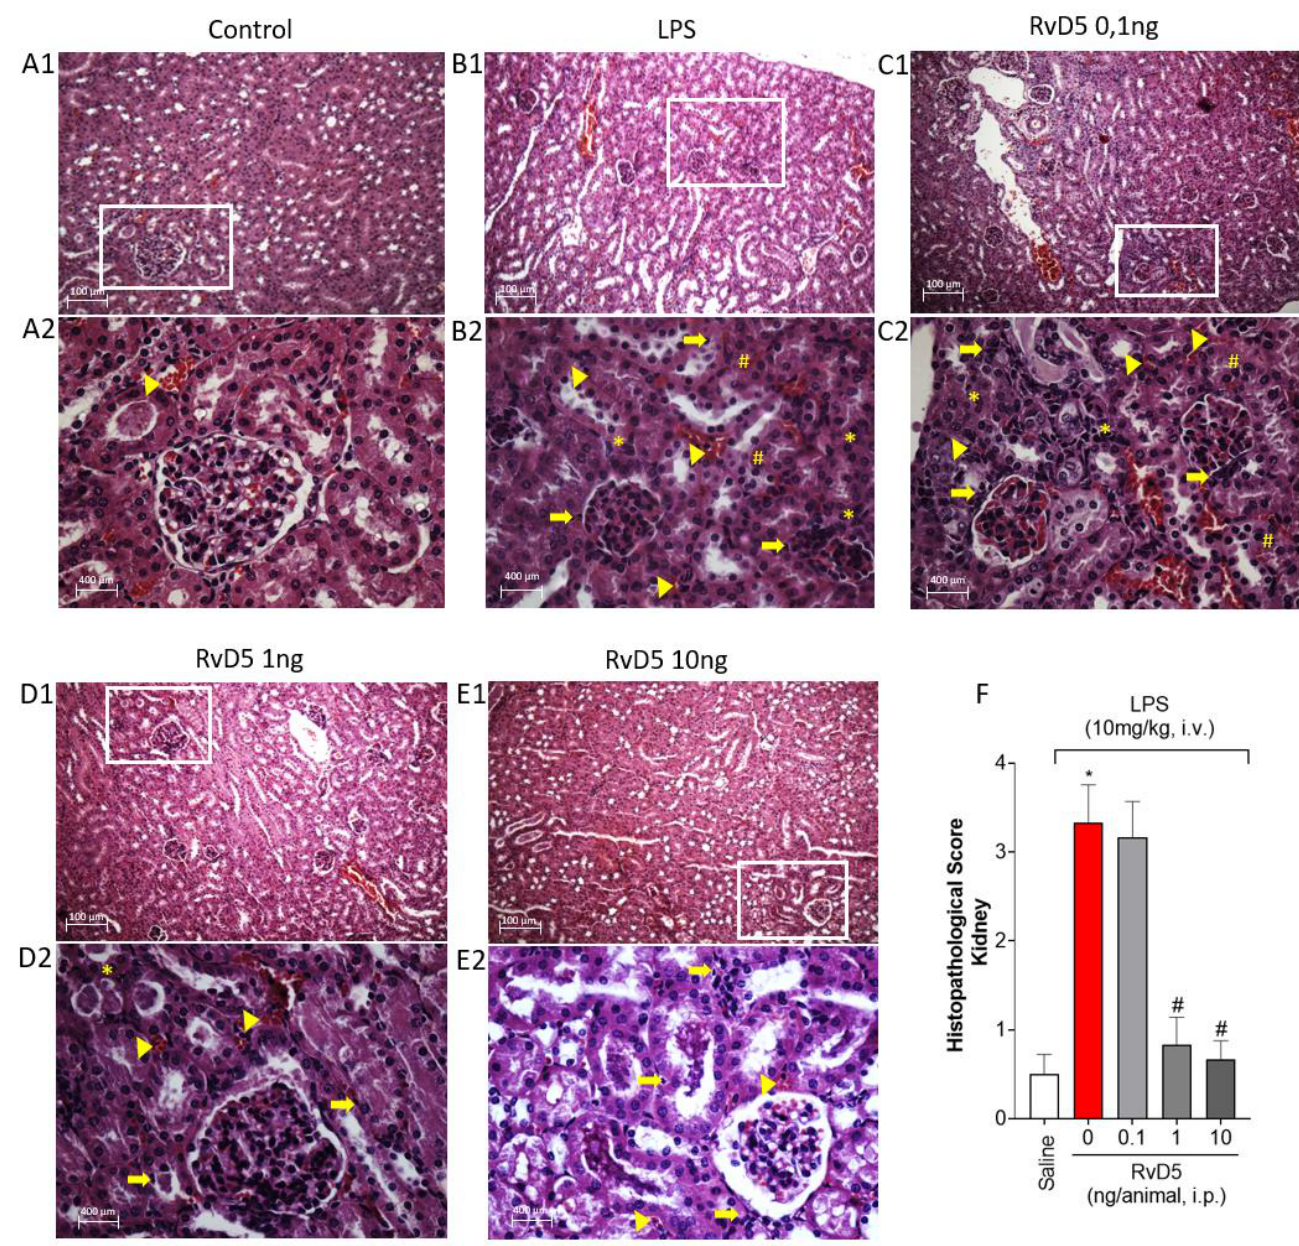
Figure 6. RvD5 preserves cortical kidney architecture in LPS endotoxemia. Representative photomicrographs of renal histology (hematoxylin and eosin, magnification 10 × and 40 × ). Control ( A1 ), LPS + vehicle ( B1 ) (10 mg/kg, i.v.), RvD5 treated at 0,1 ng ( C1 ), 1 ng ( D1 ) and 10 ng ( E1 ). ( A2 – E2 ) represent the fields with the zooms highlighted by the white rectangular inserts. Arrow: inflammatory infiltrate; Arrowhead: red blood cells; * necrotic changes; # bleeding focus. ( F ) Histopathological score. Results are presented as median + interquartile range analyzed by Kruskal-Wallis followed by Dunn’s test of six animals per group and are representative of two replicates. Scale bars: 100 and 400 µ m. (* p < 0.05 vs. saline, # p < 0.05 vs. LPS 10 mg/kg).